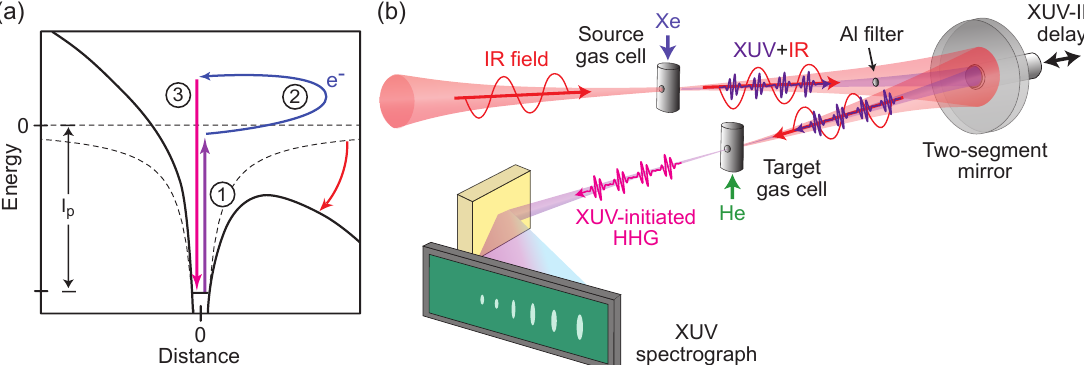
Figure 1. Principle of extreme ultraviolet (XUV)-initiated high-harmonic generation (HHG). ( a ) The absorption of an XUV photon (violet arrow) promotes an electron to the vicinity of the ionization threshold I p (step 1). A strong infrared (IR) field drives the electron on a recollision trajectory (step 2), leading to the emission of an XUV photon with higher energy (pink arrow; step 3). ( b ) Experimental setup. An IR laser pulse (red waveform) is focused into a gas cell filled with xenon, producing an attosecond XUV pulse train (violet waveform). A thin aluminum filter spatially separates the XUV and IR fields. A two-segment mirror controls the delay between the two fields and refocuses the beams into the target gas cell, filled with helium. The resulting XUV-initiated high harmonics (pink waveform) are spectrally analyzed in an XUV grating